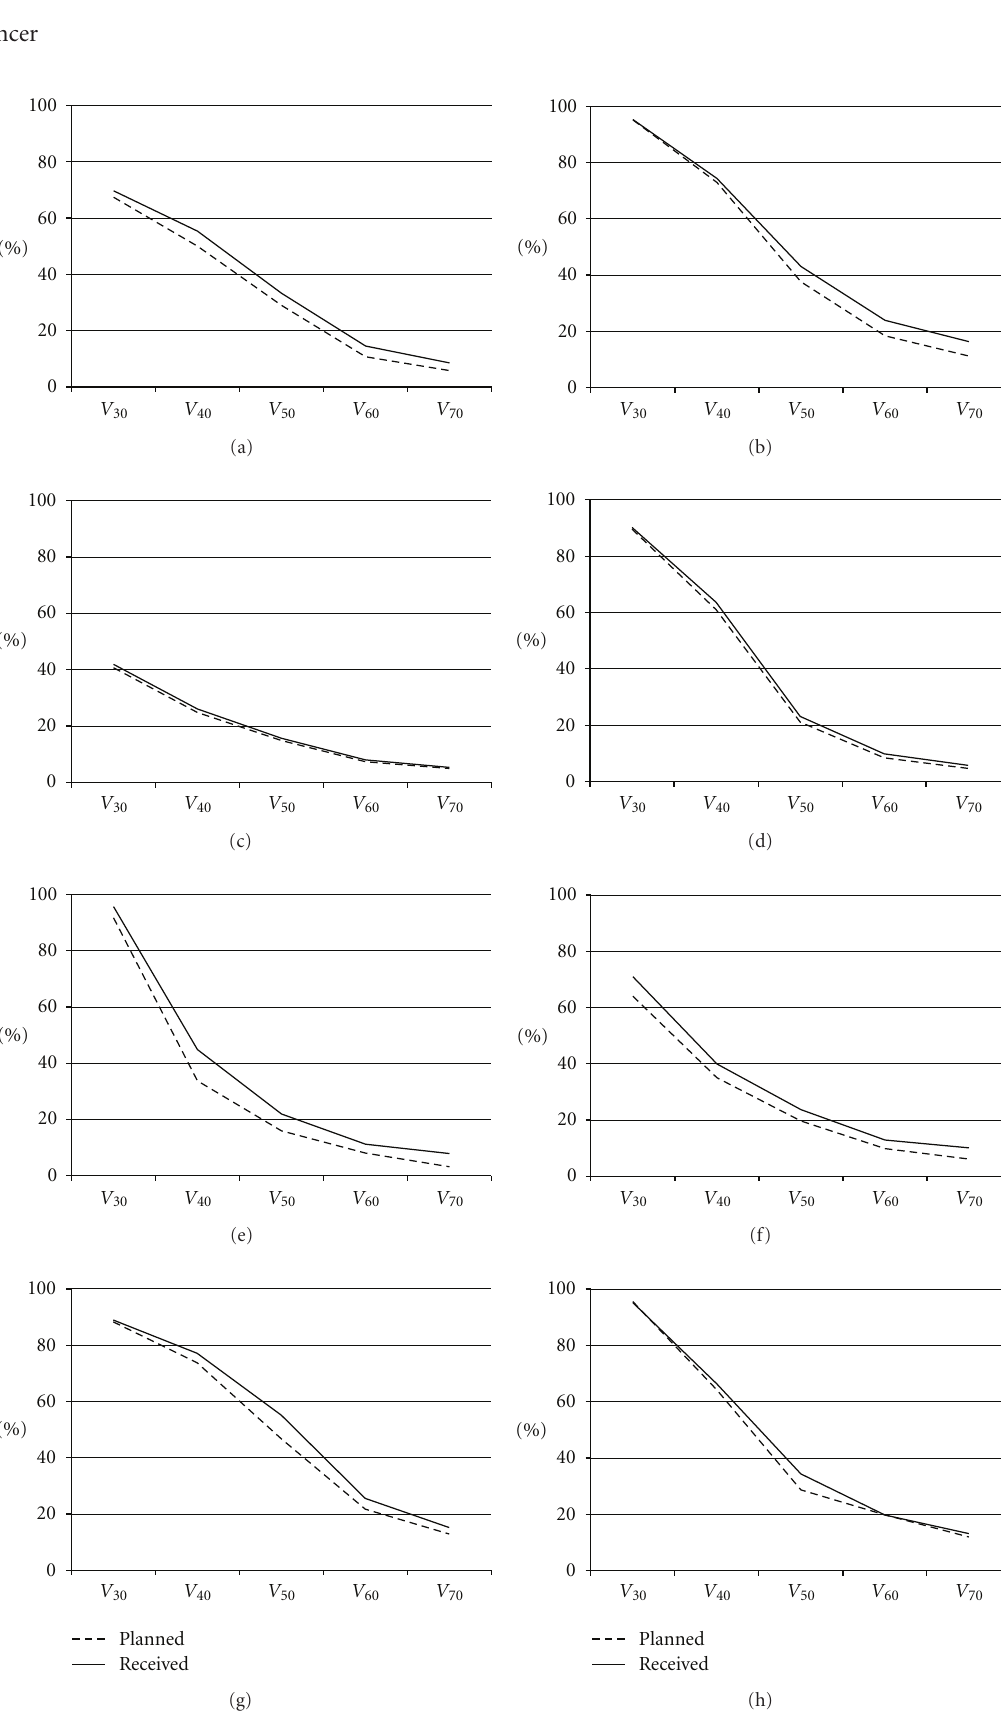
Figure 2: Average actual versus planned rectal DVHs for 8 patients experiencing late grade 2 or greater rectal